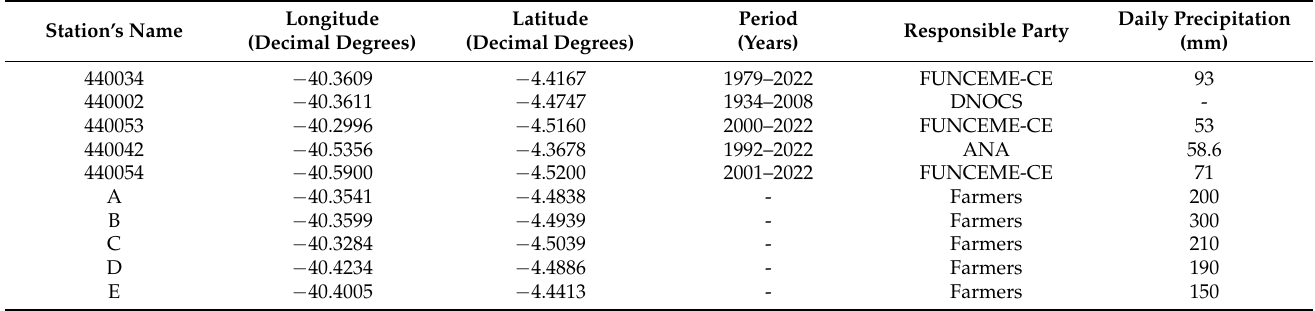
Figure 9. Meteorological gauge stations. ( a ) Localization map of the rain gauges. ( b ) Rain gauge used for the farmers to measure the precipitation. Table 1. List of selected rain gauge stations.